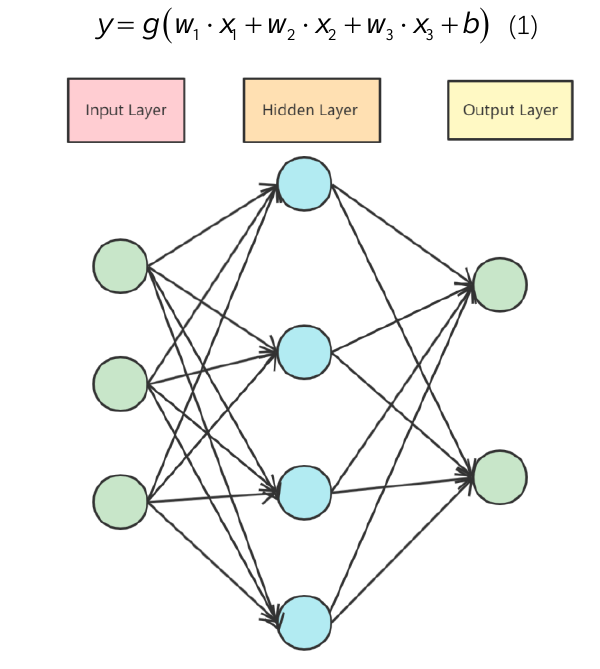
Figure 1. Classical Neural Network